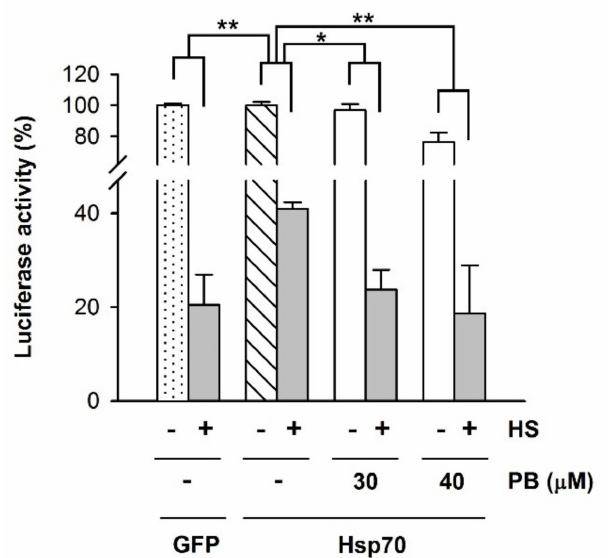
Figure 8. PB inhibits Hsp70-mediated refolding of luciferase in HEK-293 cells. Luciferase-encoding plasmids were co-transfected with plasmids encoding Hsp70 or GFP. Cells were subjected to heat shock (HS), 45 ◦ C during 30 min, and after a recovery period of 2 h at 37 ◦ C in the absence or presence of PB (30 and 40 µ M) as indicated, luciferase activity was measured. Values for samples co-expressing Hsp70 are expressed relative to that obtained for the unheated control in the absence of PB (white striped column). For cells co-expressing GFP, 100% was the corresponding control without HS (white dotted column). Statistical analysis of the heated samples (grey columns) was performed considering as 100% the luciferase activity obtained without thermal stress for each experimental condition (white columns). Data are presented as mean ± SD of three independent experiments (* p < 0.05; ** p <